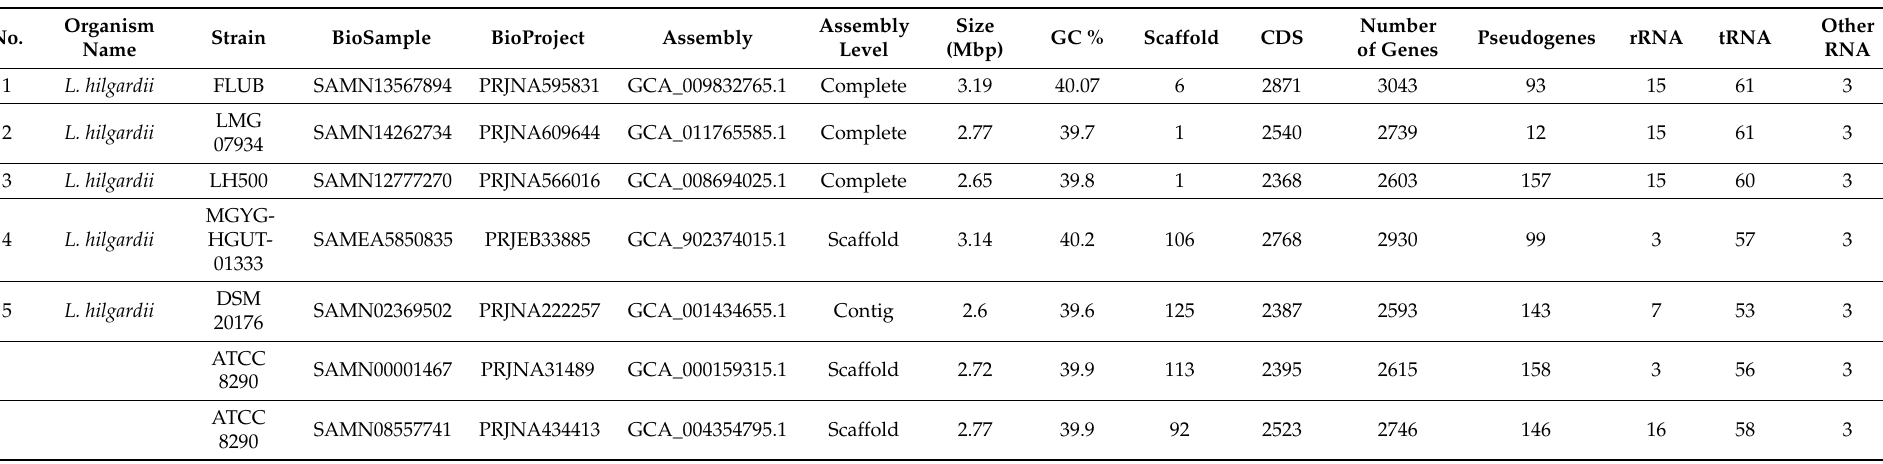
Table 2. Genomes of L. hilgardii used for pangenome analysis. Data obtained from the NCBI Genbank